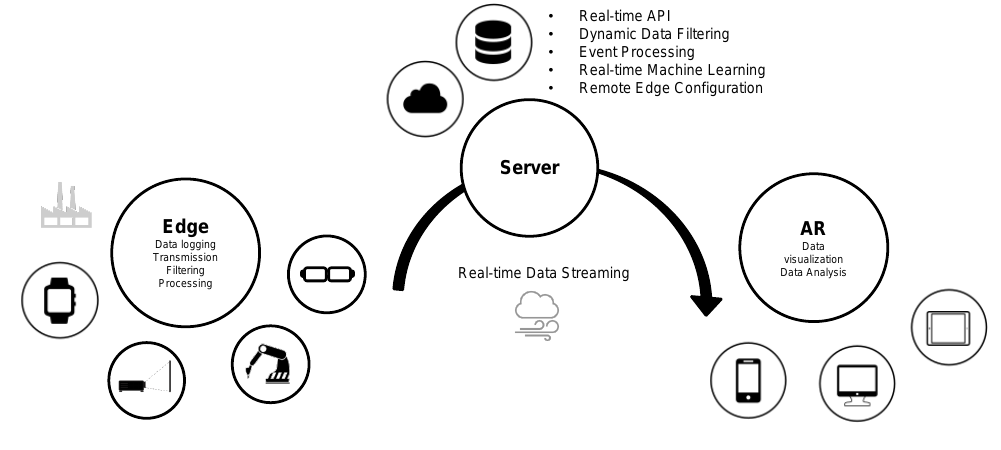
Figure 1. Middleware system